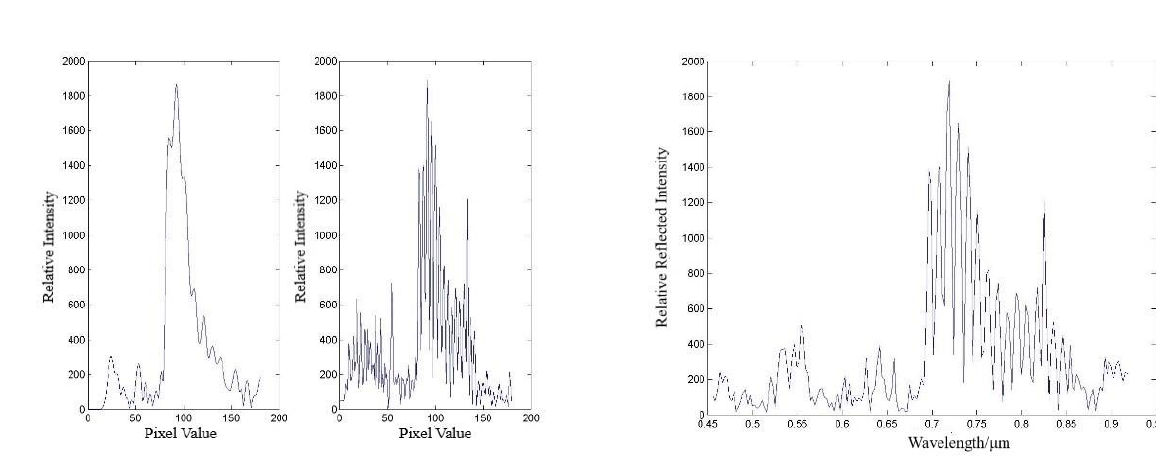
The reflection spectrum curve of the feature is used to characterize its ability to reflect electromagnetic radiation as a function of wavelength. The properties of different properties are also different from the reflectance spectra. The reflectance spectrum curve is similar in the same property, but with difference in the water content, surface structure, composition